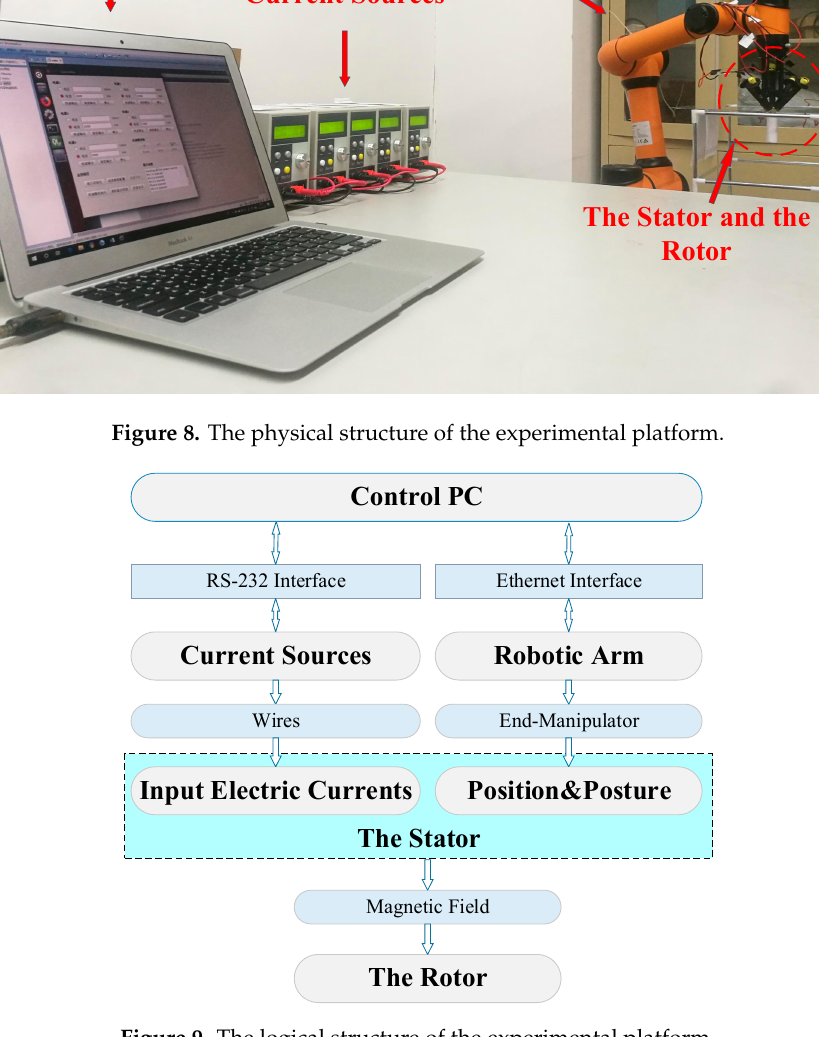
Figure 9. The logical structure of the experimental platform.